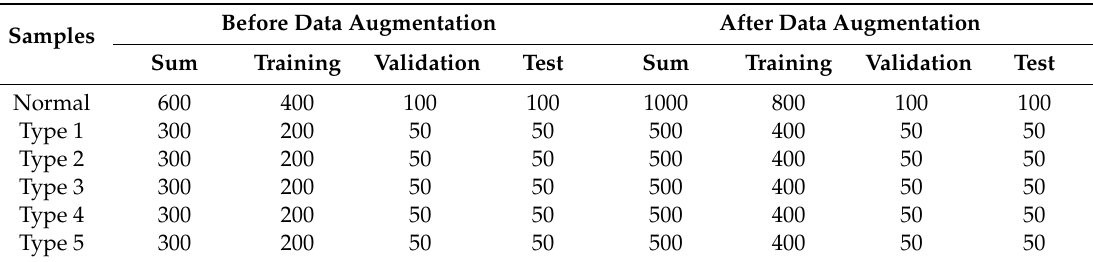
Table 3. The number of samples in the training set, validation set, and test set.